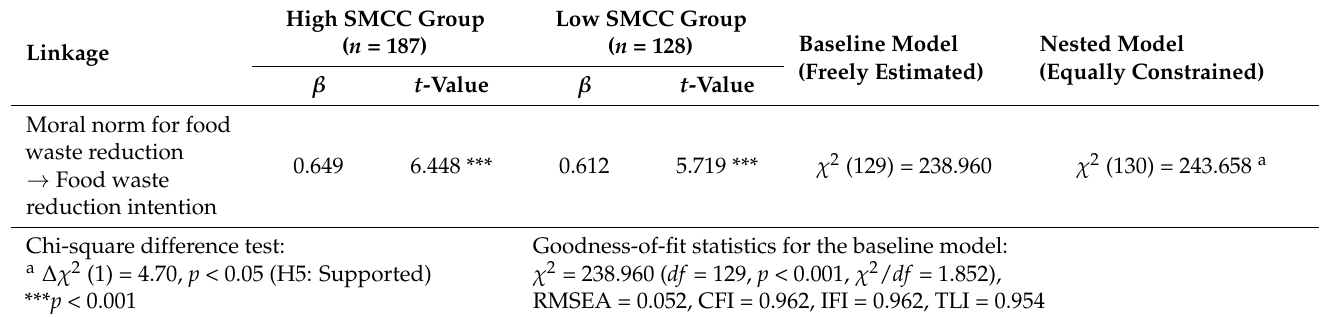
Table 5. Results of the invariance model